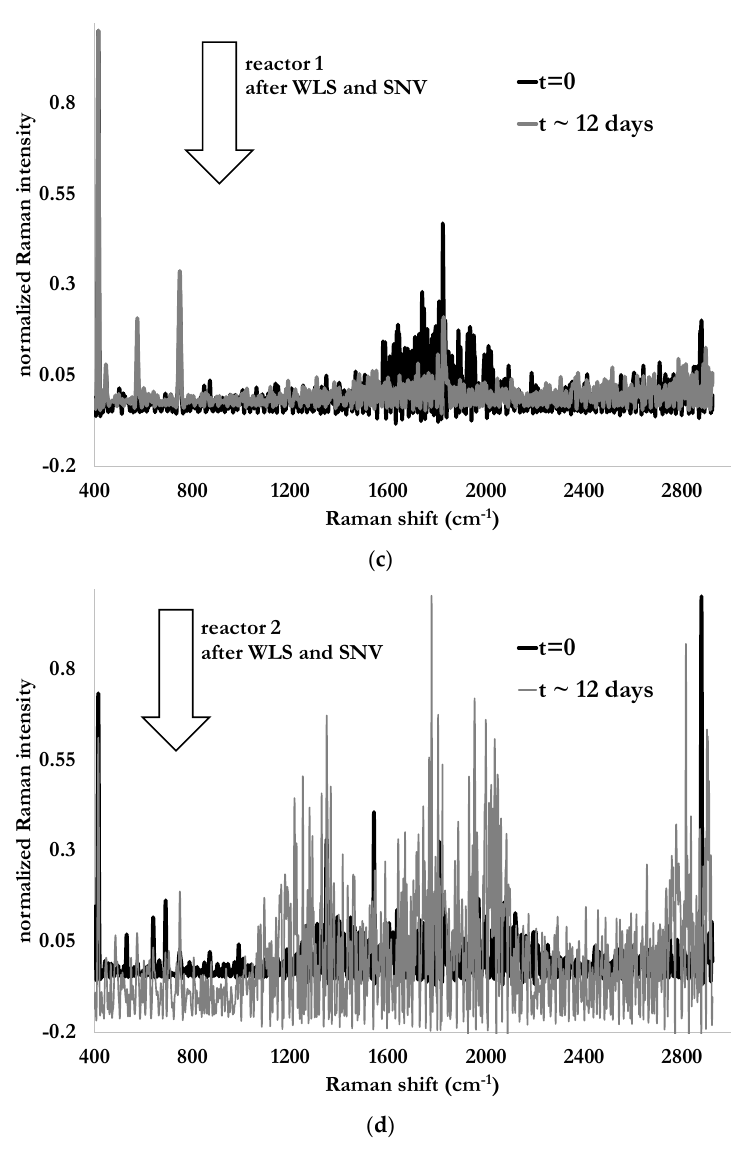
Figure 6. Raman spectra in their pristine form obtained at the beginning of the test and after 12 days from immersion probes in reactors without fire-fighting foam ( a ) and with 10 mL of fire-fighting foam Tridol S3B ( b ), and the same respective Raman spectra after Singular Normal Variate (SNV) and baseline corrections (Whittaker filter) ( c , d ).